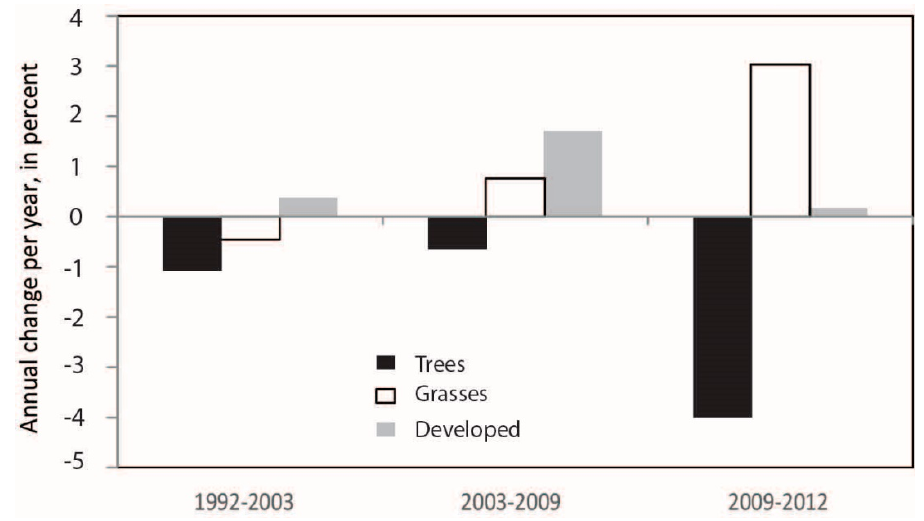
Figure 5. Change in selected land-cover categories within unincorporated Johnson County, KS, USA, during 1992–2012.